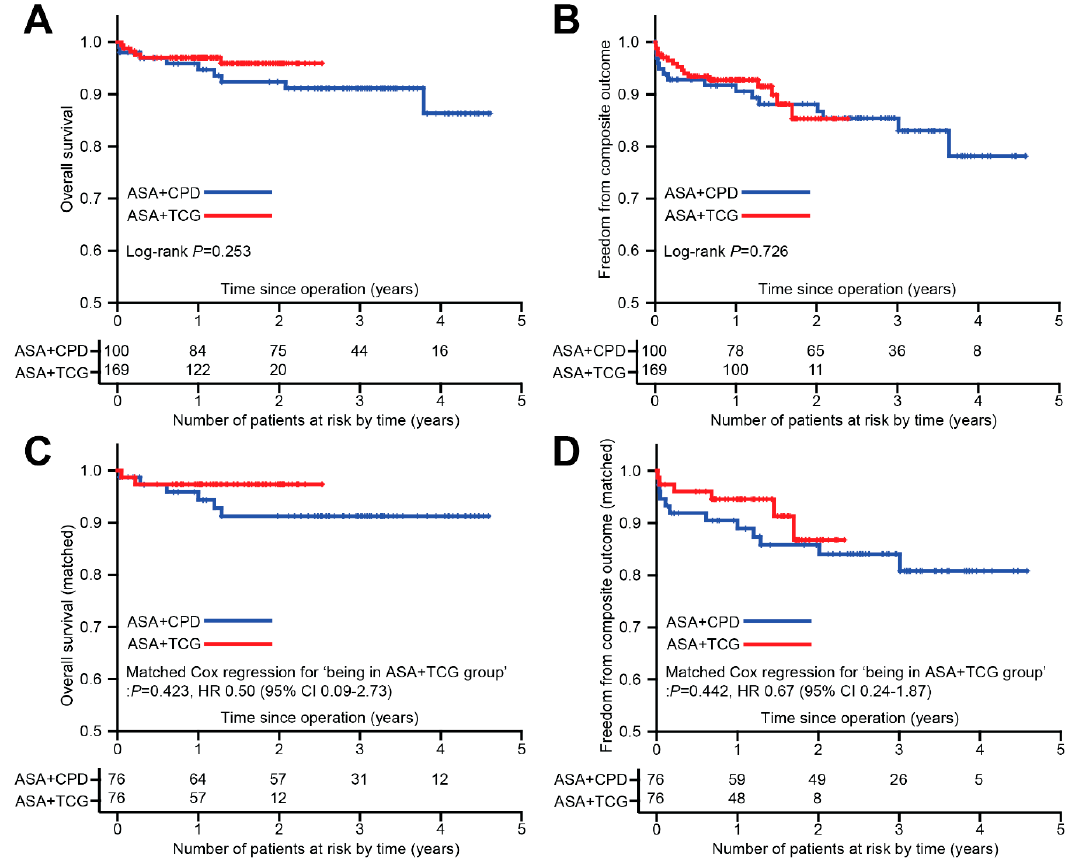
Figure 3. Survival analysis (Kaplan–Meier analyses) for all 269 patients and matched patients. ( A ) overall survival (all patients). ( B ) composite endpoint of major adverse cerebrovascular and cardiovascular event (MACCE) + major bleeding (all patients). ( C ) overall survival (propensity score-matched). ( D ) composite endpoint of MACCE and major bleeding (propensity score-matched). Crosshair means censored data. ASA, acetylsalicylic acid; CI, confidence interval; CPD, clopidogrel; OR, odds ratio; TCG, ticagrelor. Table 4. Multivariable analysis (Cox proportional hazard ratio model) for composite outcomes of major adverse cerebrovascular and cardiovascular event (MACCE) and major bleeding.